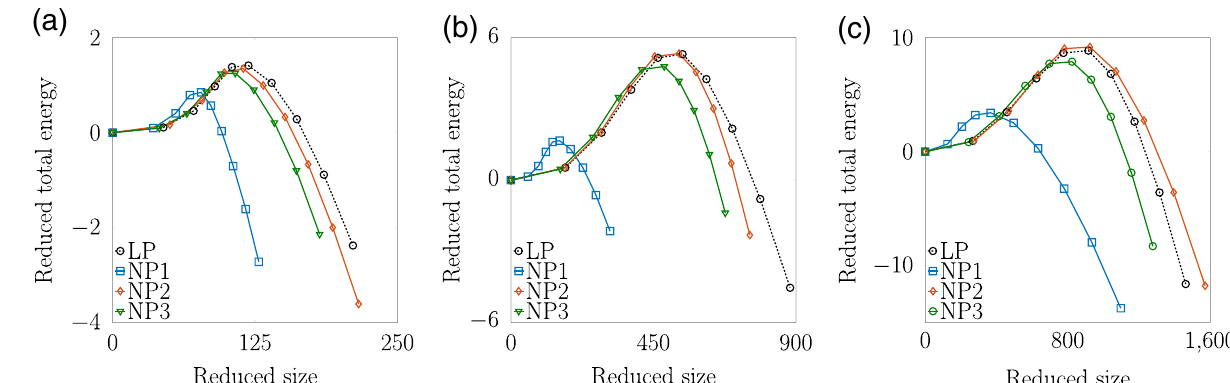
Fig. 5 Critical nucleus con fi guration for different transformation pathways (from left to right column: LP, NP1, NP2, and NP3) when elastic to chemical energy ratio is ( a – d ) ξ = 0.5, ( e – h ) ξ = 0.8, and ( i – l ) ξ = 1.0. Two colors represent two different orientational